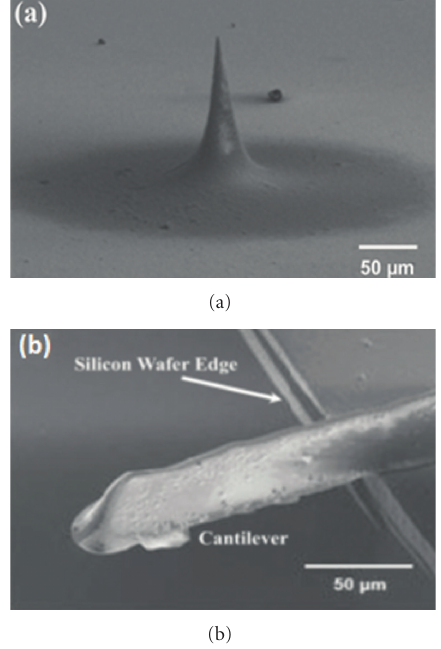
Figure 6: SEM image of CdSe/ZnS core/shell nanocrystal-based features printed using aerodynamic lenses; (a) microtower, (b) microline, from Qi et al. [15], Aerosol Science and Technology, Copyright 2010, Mount Laurel, NJ. Reprinted with